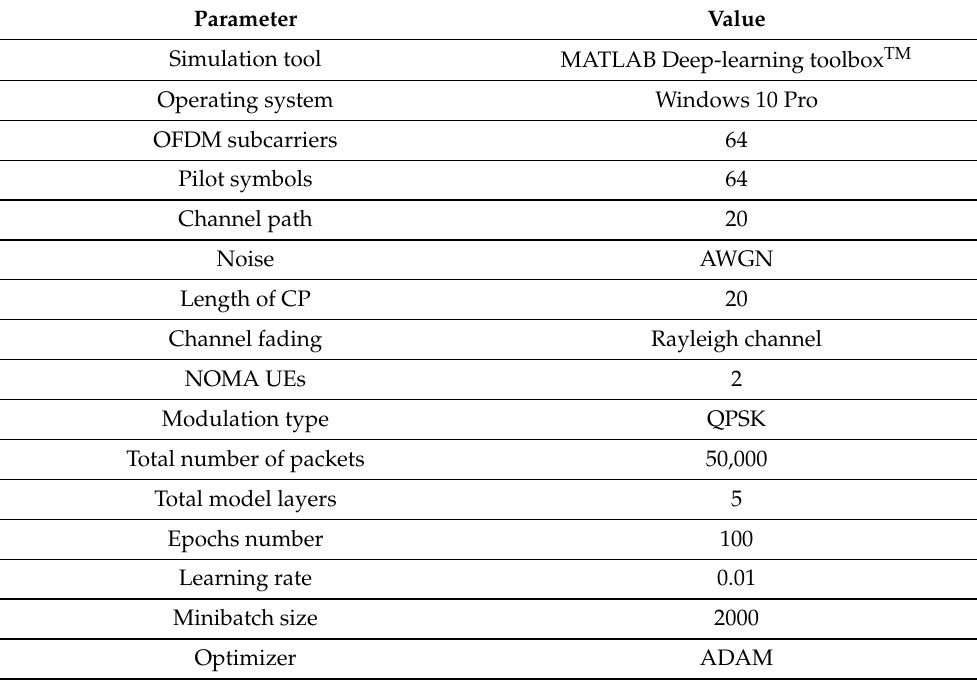
Table 1. The simulation